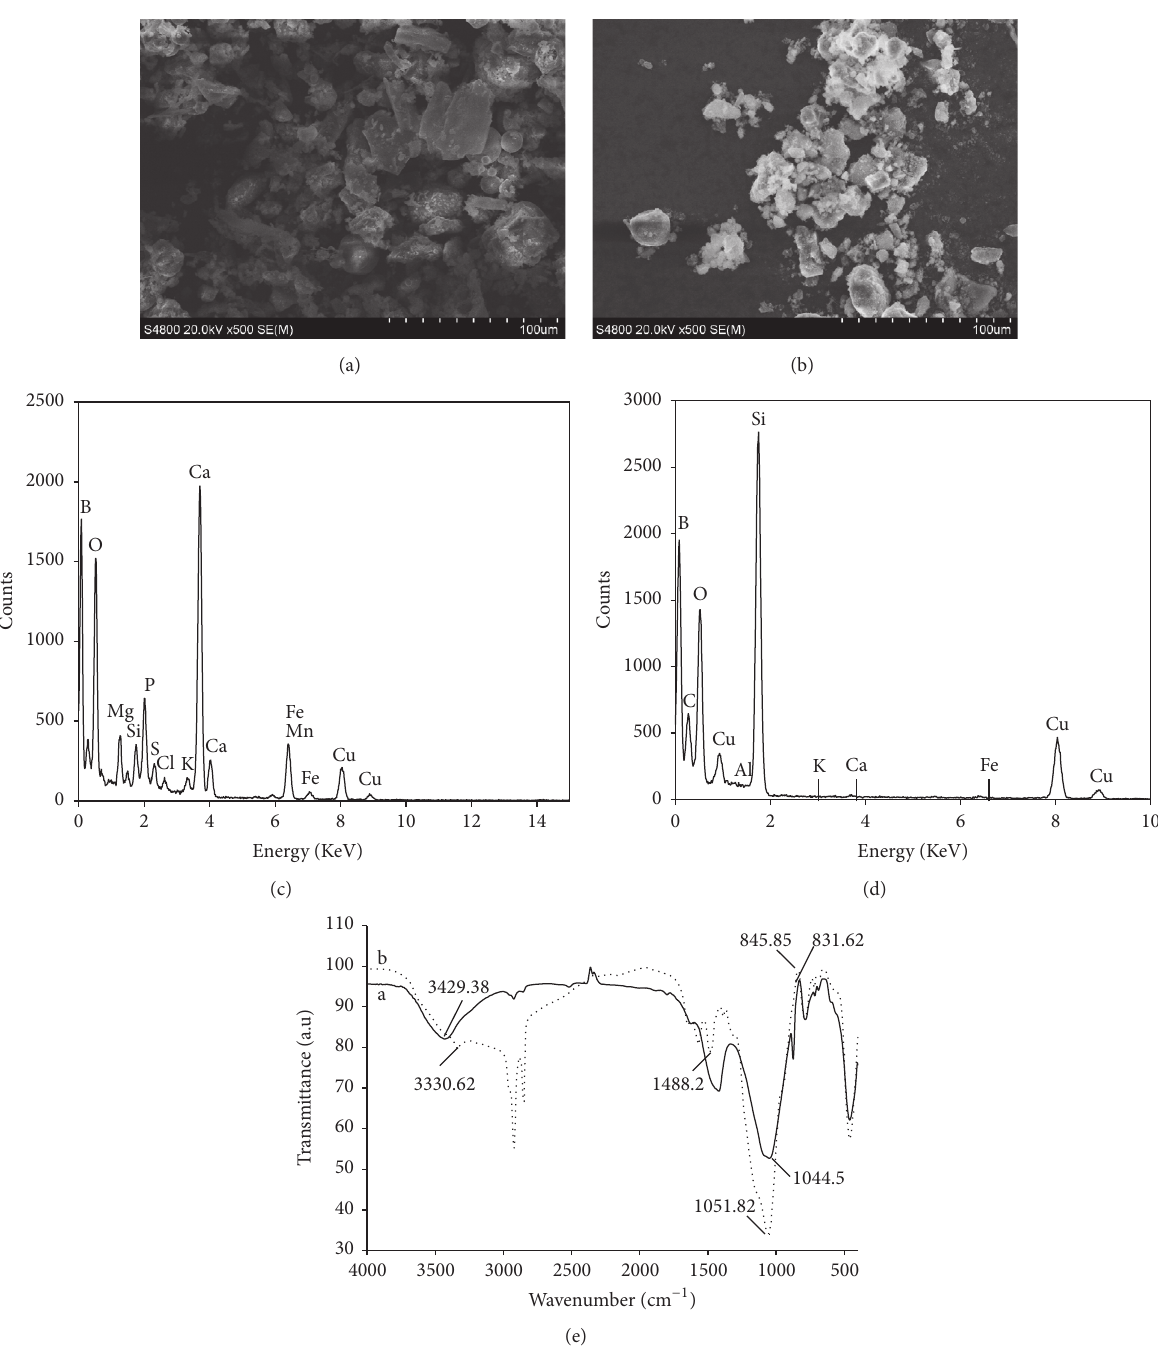
Figure 1: (a) SEM of biomass ash at 20KeV; magnification 500. (b) SEM of synthesized matrix at 20 keV; magnification 500. (c) EDS analysis of elemental composition of biomass ash. (d) EDS analysis of elemental composition of modified biomass ash and (e) FT-IR spectra: (a) biomass ash and (b) synthesized